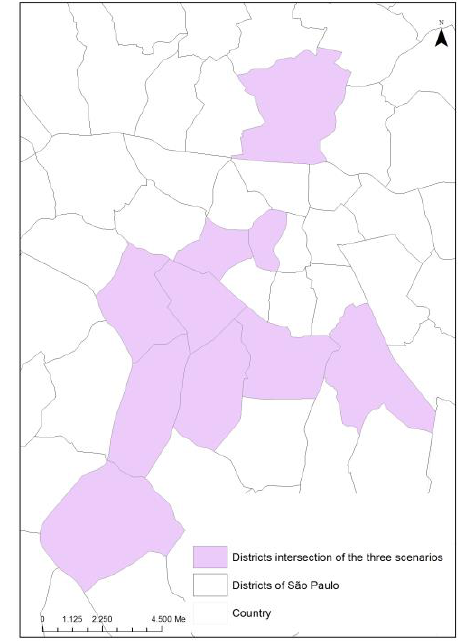
Figure 10. Preferential districts for carsharing system implementation according to scenario 1. (Source: Authors)